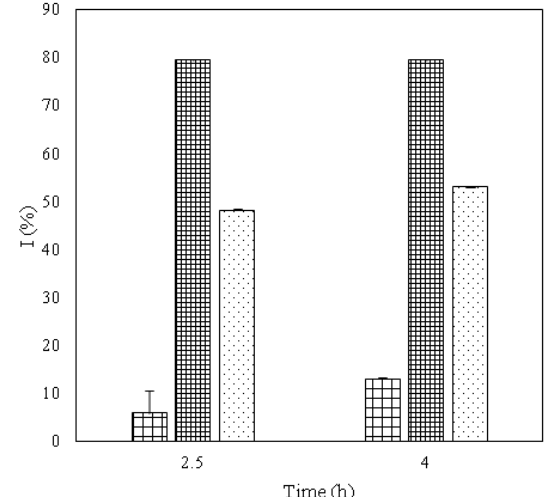
Figure 3. Antioxidant activity, inhibition (%) of film forming solutionof sodium caseinate ( ), sodium caseinate/gallic acid 50 μg/mL ( ), and sodium caseinate/rosemary essential oil 1.5% ( )( w / v ), after 2.5 and 4 h of contact with DPPH radicals at room temperature.